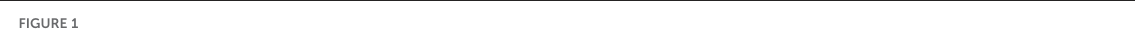
FIGURE1 showing dense bacterial aggregates with cell surface RPA-lectin glycoconjugates and reflection signal. Color allocation: lectin—green, reflection–gray. Axial dimension: 42 µ m, 86 optical sections. (B) Danube river snow aggregate showing ECA-lectin glycoconjugates. Color allocation: lectin–green, autofluorescence of chlorophyll–blue, and reflection–gray. Axial dimension: 59 µ m, 60 optical sections. (C) Cave snotty sample with double lectin staining showing globular and filamentous lectin glycoconjugates. Color allocation: AAL-lectin–green, PNA-lectin–red, nucleic acid stain–blue, and reflection–gray. Axial dimension: 74 µ m, 75 optical sections. (D) Biofilm reactor (white water) with star-like microcolonies linked by VVA-specific lectin glycoconjugates. Color allocation: lectin–green, nucleic acid stain–red. Axial dimension: 87 µ m, 88 optical sections. (E) Rotating annular reactor biofilm developed from Elbe river water and fed with methanol. The young biofilm shows single cells and microcolonies covered with HPA-lectin glycoconjugates. Color allocation: nucleic acid stain–green, lectin–red. Axial dimension: 29 µ m, 30 optical sections. (F) Anammox floc from a laboratory reactor showing PHA-E-lectin glycoconjugates. Color allocation: nucleic acid stain–green, lectin–red. Axial dimension: 34 µ m, 18 optical sections. (G) Freshwater tufa sample showing net-like AAL-lectin glycoconjugates. Color allocation: lectin–green, autofluorescence overlay of phycobilin and chlorophyll–purple, and reflection–gray. Axial dimension: 118 µ m, 60 optical sections. (H) Flow lane biofilm developed from river Elbe water showing diatoms with cell surface AAL-lectin signal and bacterial colonies embedded in AAL-lectin glycoconjugates. Color allocation: nucleic acid stain–green, lectin–red, and autofluorescence of chlorophyll–blue. Axial dimension: 50 µ m, 51 optical